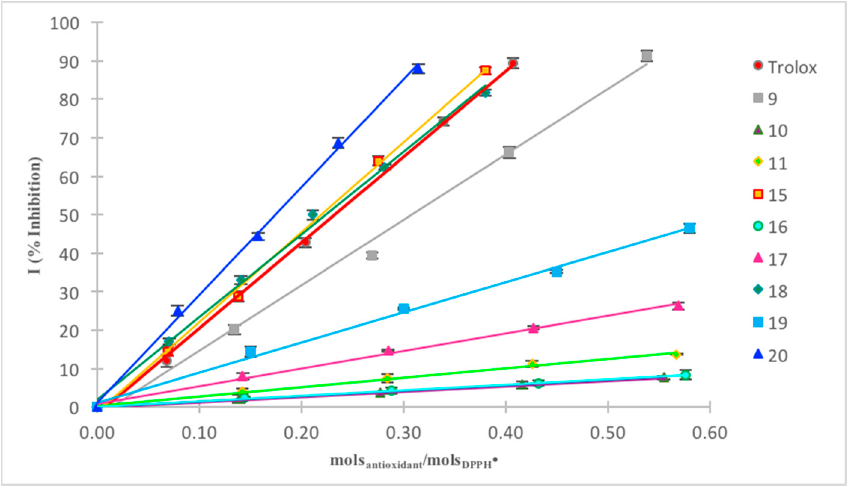
Figure 2. Regression line of the tested compounds 9 – 11 and 15 – 20 in DPPH assay in methanol.